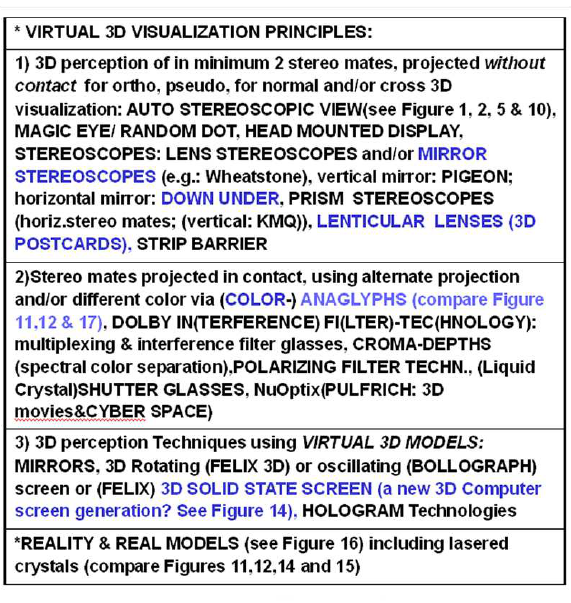
Table 1. 3D visualization methods - the complete list